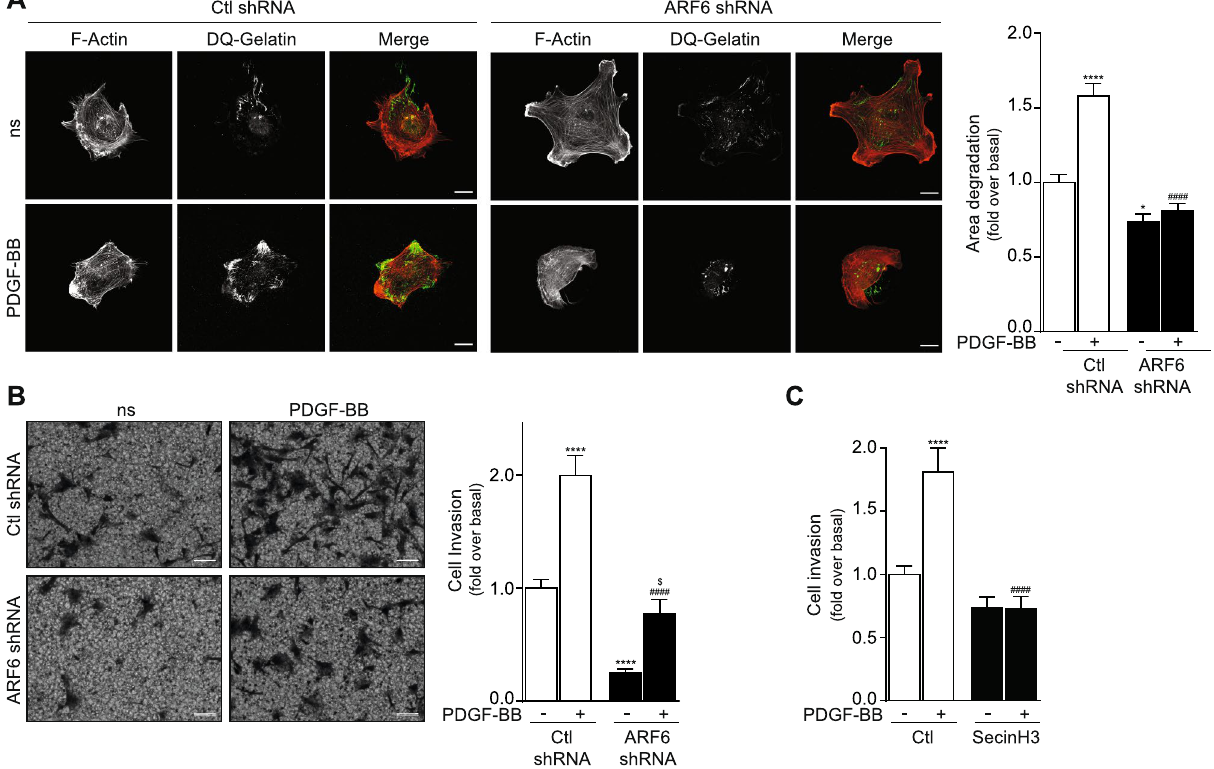
Figure 2. ARF6 modulates PDGF-BB-mediated invasion in HASMC. ( A ) Cells were infected with a Ctl or ARF6 shRNA and seeded onto DQ gelatin for 1 h. They were stimulated with PDGF-BB (25 ng/mL). After 6 h, cells were fixed and actin stained using Alexa Fluor 568 phalloidin. Images are representative of the degradation area of four independent experiments with 30 cells examined per condition. Quantifications are the mean ± SEM of four independent experiments. ****P < 0.0001, *P < 0.05 comparison for the basal condition, #### P < 0.0001 comparison for Ctl shRNA PDGF-BB (Two-Way Anova) (bar = 20 µm). ( B ) 100 000 cells were infected as in ( A ) and seeded into Matrigel-coated Boyden chambers for 1 h. Afterwards, cells were left untreated (non-stimulated; ns) or stimulated with PDGF-BB (25 ng/mL) for 24 h. Images are from the lower part of the membrane and are representative of five images taken per condition. Quantifications are the mean ± SEM of six independent experiments. ****P < 0.0001 are values compared to the basal condition, ####P < 0.0001 compared to Ctl shRNA PDGF-BB conditions, $ P < 0.05 compared to ARF6 shRNA ns (Two-Way Anova) (bar = 100 µm). ( C ) 100 000 cells were seeded into Matrigel-coated Boyden chambers and pretreated with DMSO (Ctl) or SecinH3 (30 µM) for 1 h. One set of cells was left untreated (non-stimulated; ns) and the other was stimulated with PDGF-BB (25 ng/mL) for 24 h. Quantifications are the mean ± SEM realised on five independent experiments. ****P < 0.0001 are values compared to basal condition, #### P < 0.0001 compared to Ctl PDGF-BB (Two-Way